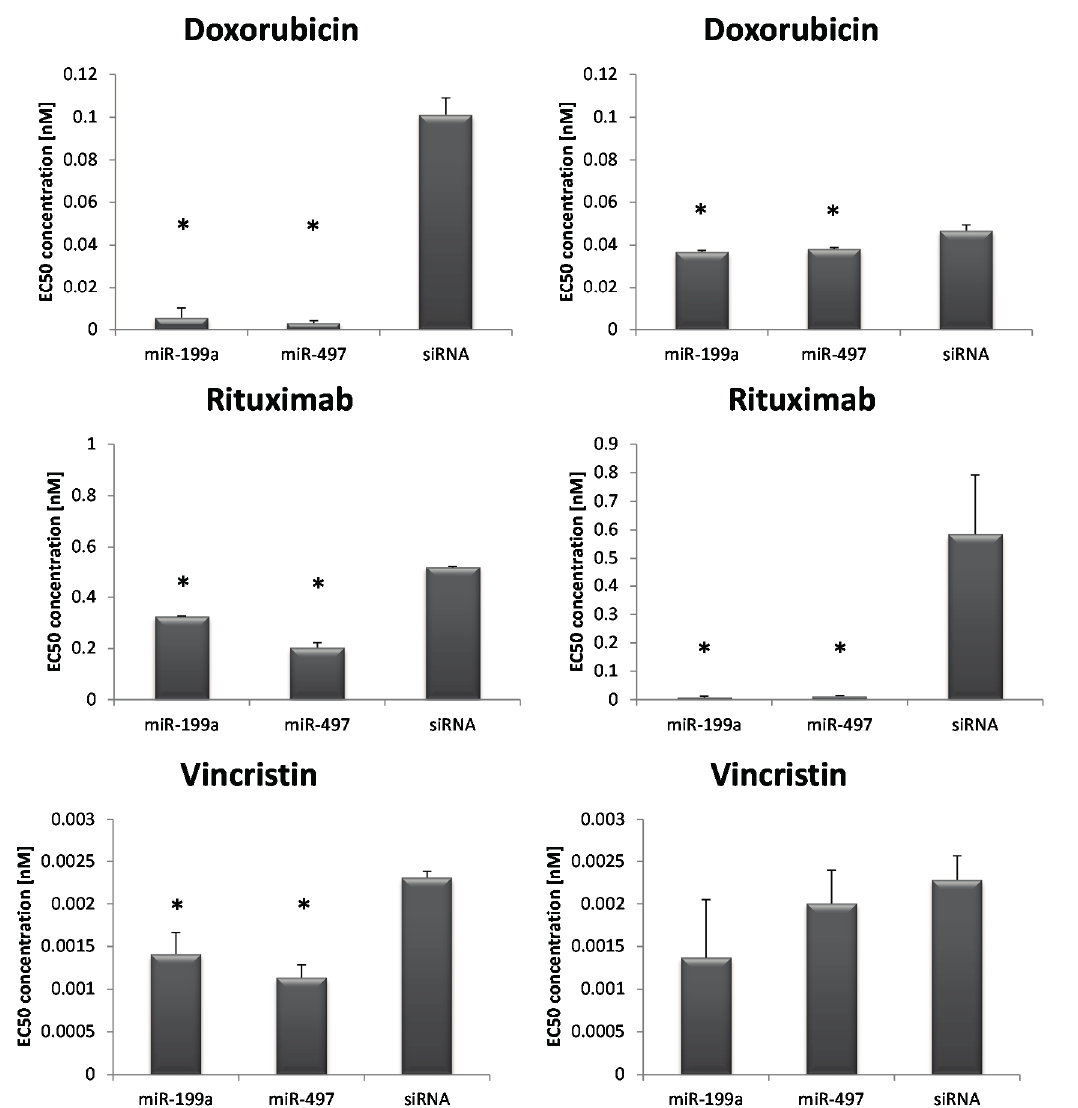
Figure 3. Screening test with 3-(4,5-dimethylthiazol-2-yl)-5-(3-carboxymethoxyphenyl)-2- (4-sulfophenyl)-2H-tetrazolium (MTS) assay. EC 50 (half maximal effective concentration) concentrations of doxorubicin, rituximab and vincristin of transfected RI-1 ( left column ) and SUDHL4 ( right column ) cells. Each bar represents the mean values of the EC 50 concentration in nM ± standard deviation of either miR-199a or miR-497 transfected cells or siRNA control, respectively. The comparison of the expression levels was performed by using the Mann–Whitney U test. * indicates reduced EC 50 concentration compared to siRNA ( p <